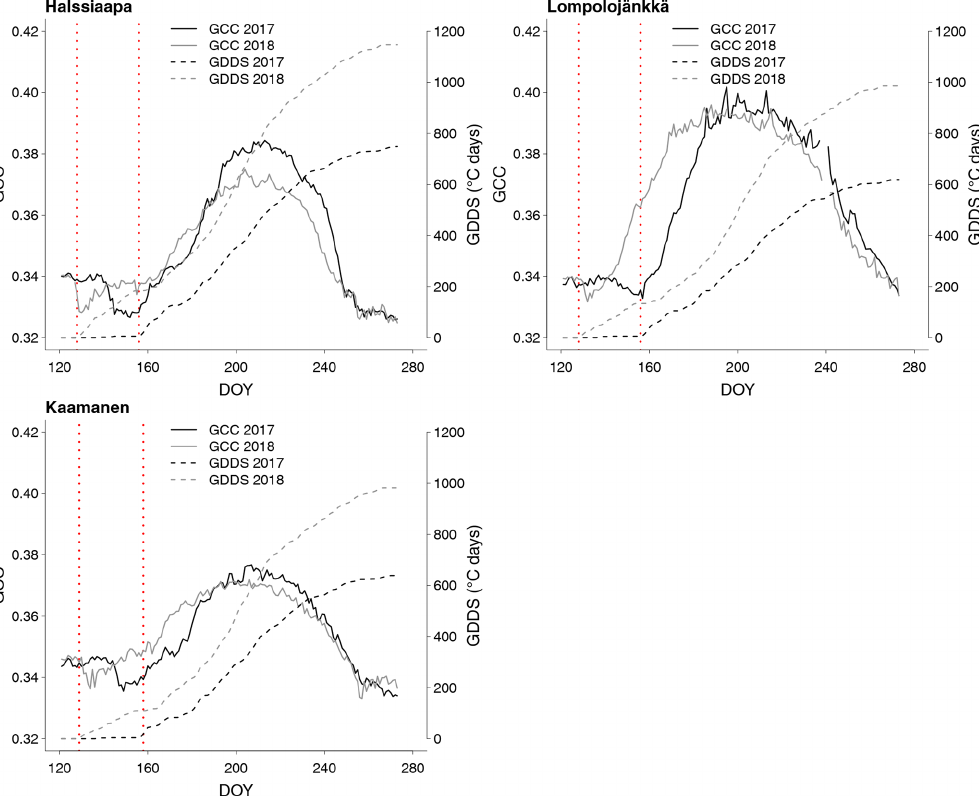
Figure 5. Development of GCC and growing degree day sum (GDDS) from 1 May to 30 September at Halssiaapa, Lompolojänkkä and Kaamanen. The years 2017 and 2018 are shown here as an example of a cold and warm spring, respectively. The grey dashed lines indicate the start of the growing